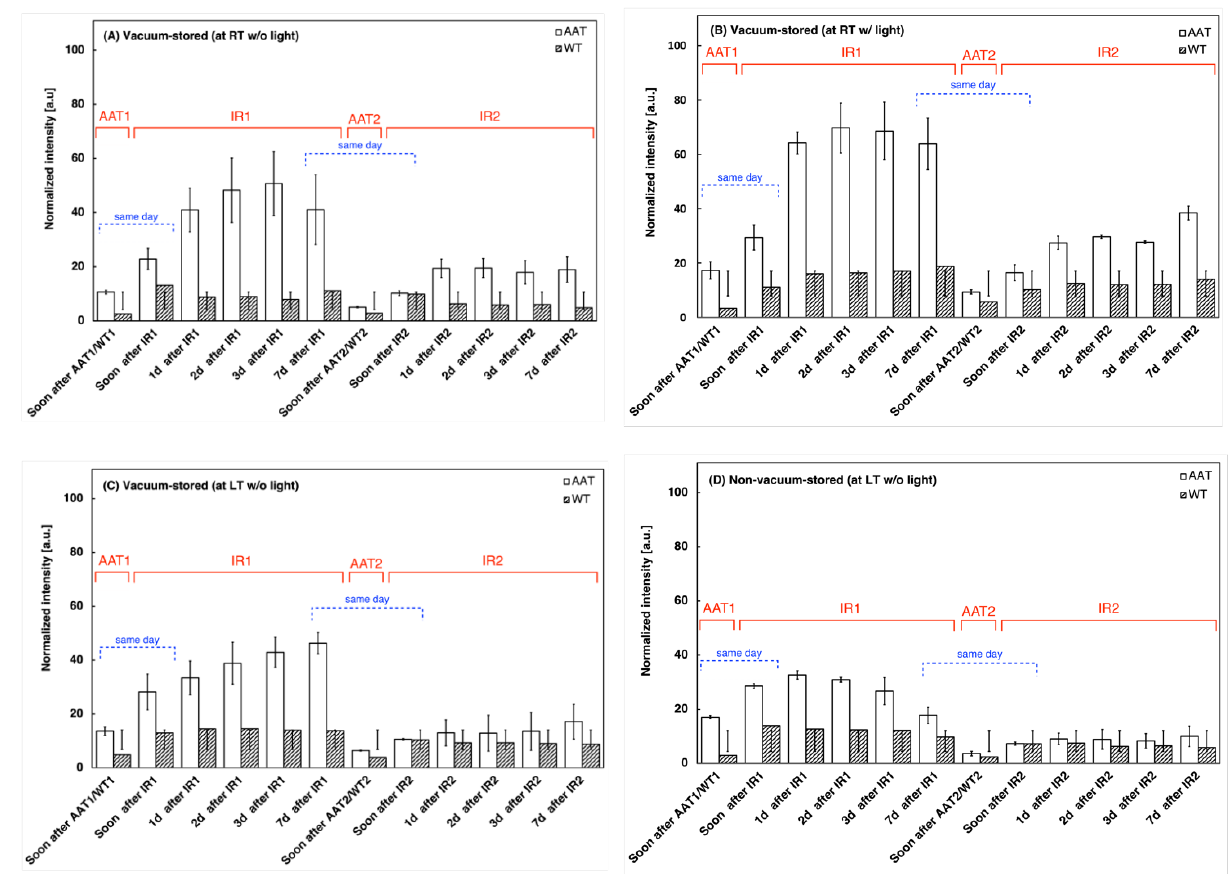
Figure 4. Comparison of the effects of repeated L(+)-ascorbic acid (AAT) or water treatments (WT) and X-ray irradiations (IR) to the ESR peak-to-peak intensities in samples stored under four different location conditions, as described in steps 1–4 of Experiment 1. Each point of the AAT samples in the plot was calculated as the average of three samples and subtracted from the WT control sample. The error bars on the AAT samples were obtained as the standard deviation of three samples, while one standard deviation was used for the WT sample. Note that “soon after AAT1” and “soon after IR1” were performed on the same day, as well as the “7d after IR1”, “soon after AAT2”, and “soon after IR2”. The notations RT and LT correspond to room temperature (20 ◦ C) and low temperature ( − 20 ◦ C), respectively. The with (w/) and without (w/o) light imply that the samples were placed in ambient illumination and in darkness,